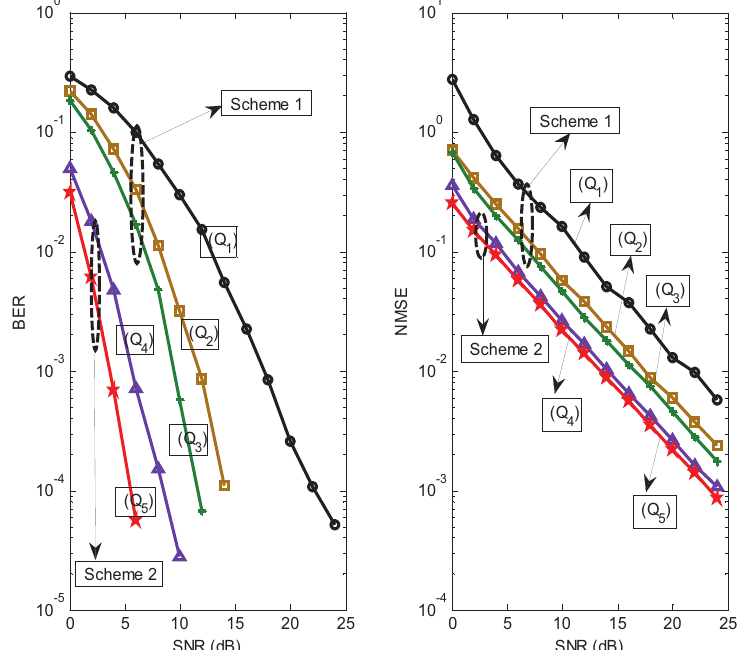
Figure 9. Performances of the proposed receiver for different